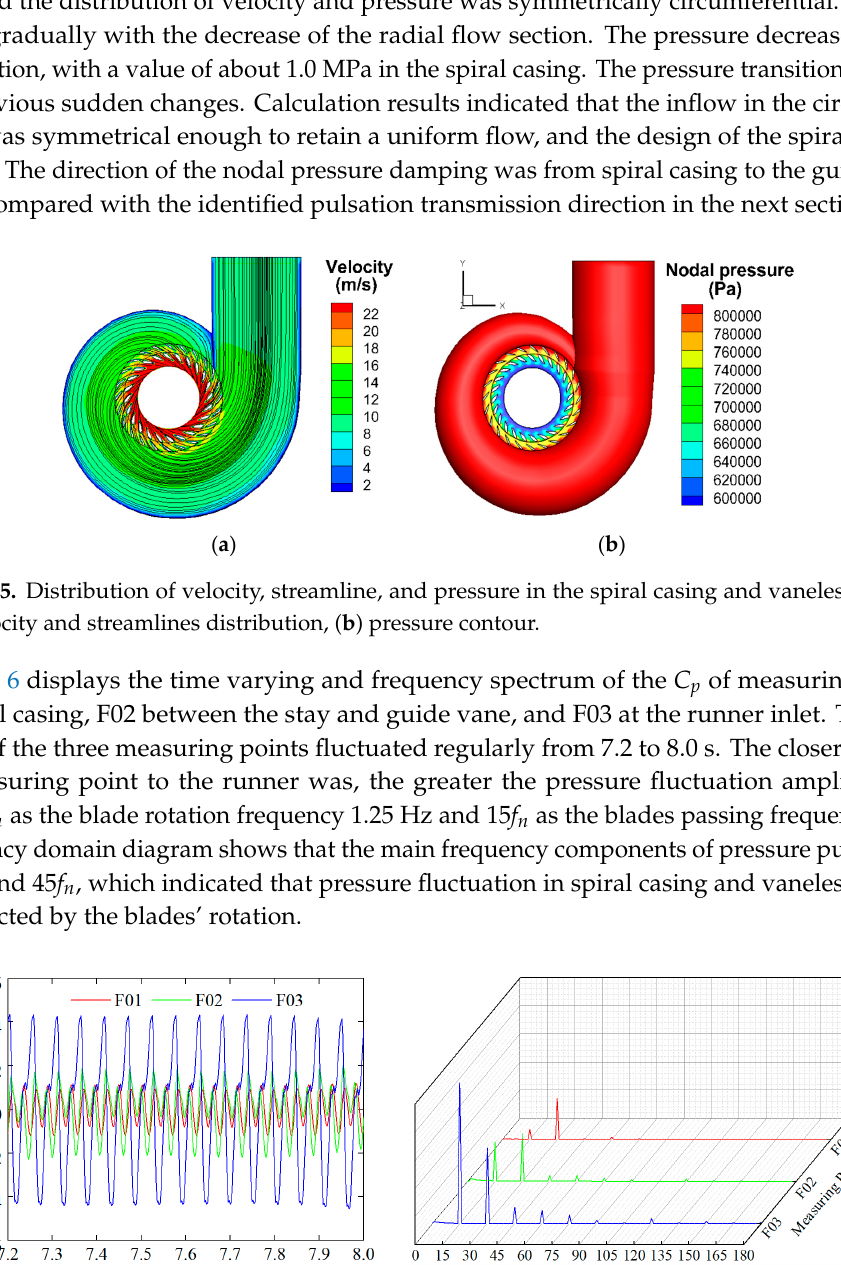
Figure 6. Time and frequency analysis of C p at the measuring points F01~F03. ( a ) Time domain graph, ( b ) frequency domain graph.